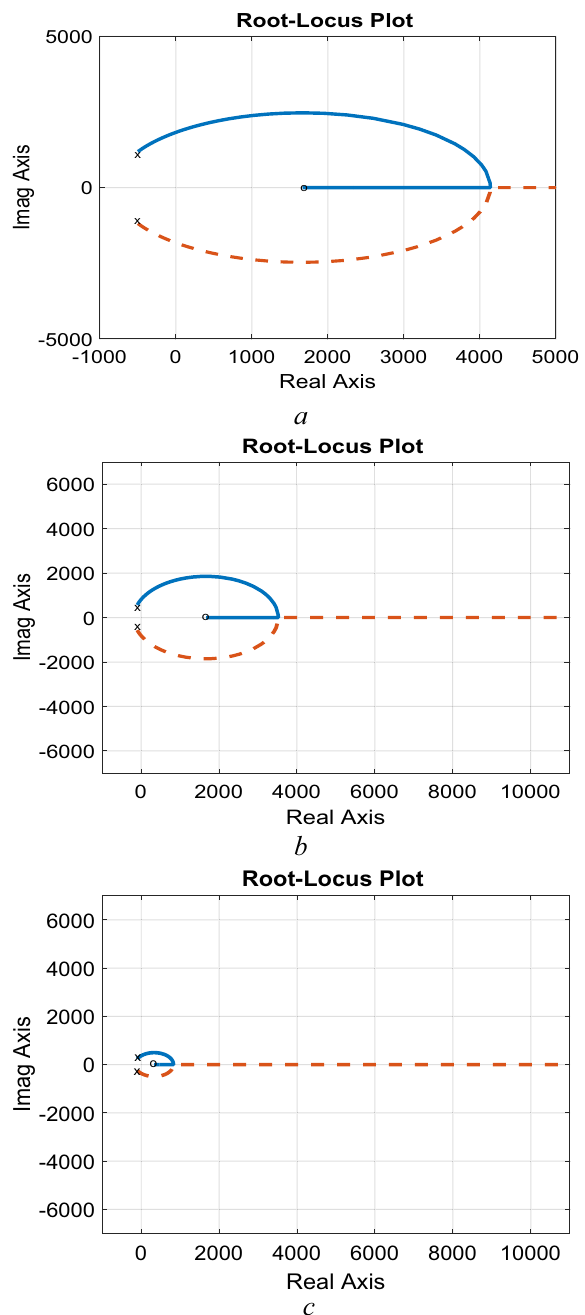
Figure 6. Effects of varying the capacitance, Pole-Zero. ( a ) L = 15 mH, C = 5 μF, ( b ) L = 15 mH, C = 50 μF, ( c ) L = 15 mH, C = 150